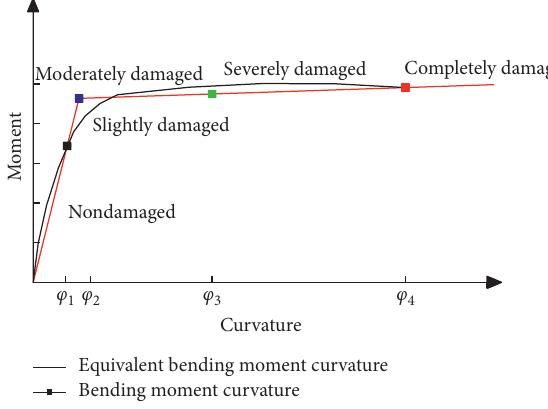
Figure 1: Schematic diagram of damage state interval.